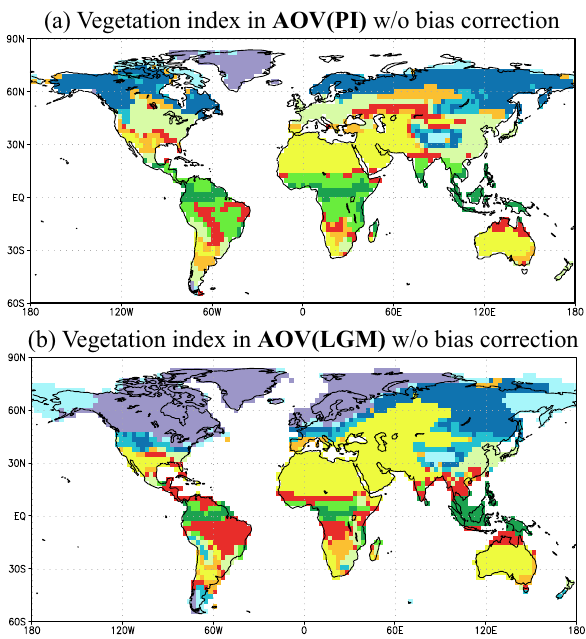
Fig. A1. The same as Fig. 1 but without bias correction (a) Fig. A1. As same as Figure1 but without bias corrected (a) AOV(PI) and (b) AOV(LGM) . AOV(PI) and (b) AOV(LGM).